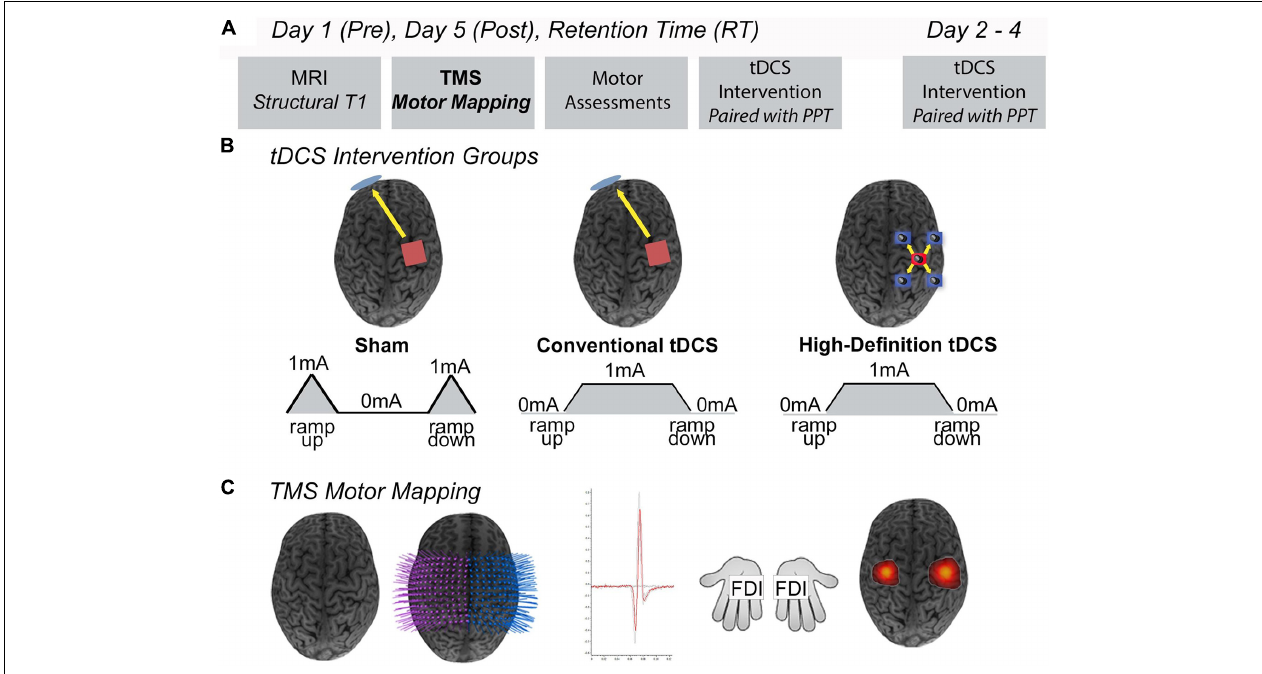
FIGURE 1 | Study design. (A) On Day 1 (pre), participants completed an MRI protocol (90 min), robotic TMS motor mapping (90 min), and the Purdue Pegboard Task (PPT) (10 min), with a 15-min break between each assessment. Days 2–4, participants received five consecutive days of tDCS while training their left hand on the PPT task (PPT L ). Day 5 (post), participants received their final tDCS stimulation protocol and proceeded to complete the same MRI protocol, TMS motor mapping, and PPT as Day 1. At a 6-weeks retention time (RT), participants repeated all assessments received on Day 1 (MRI, robotic TMS motor mapping,